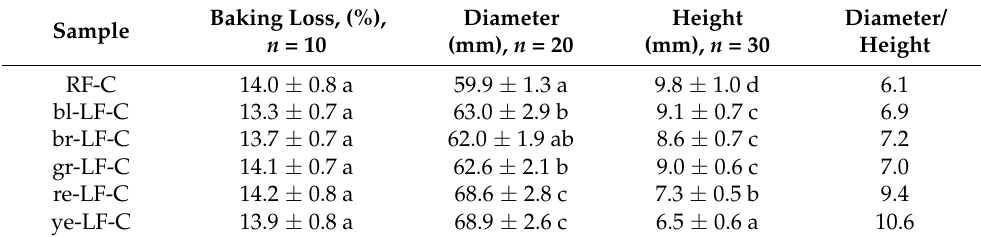
Table 5. Baking loss, diameter and height of rice and lentil